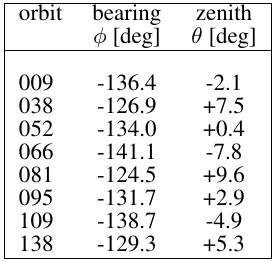
Table 1. Mean acquisition angles over Negribreen from different relative Sentinel-2